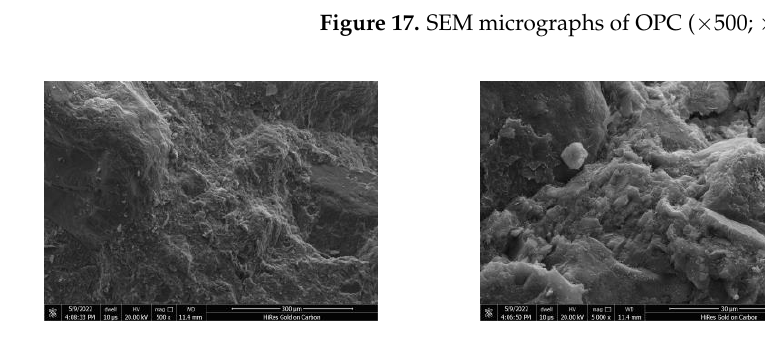
Figure 18. SEM micrographs of DC5 (×500; ×5000; ×30,000).